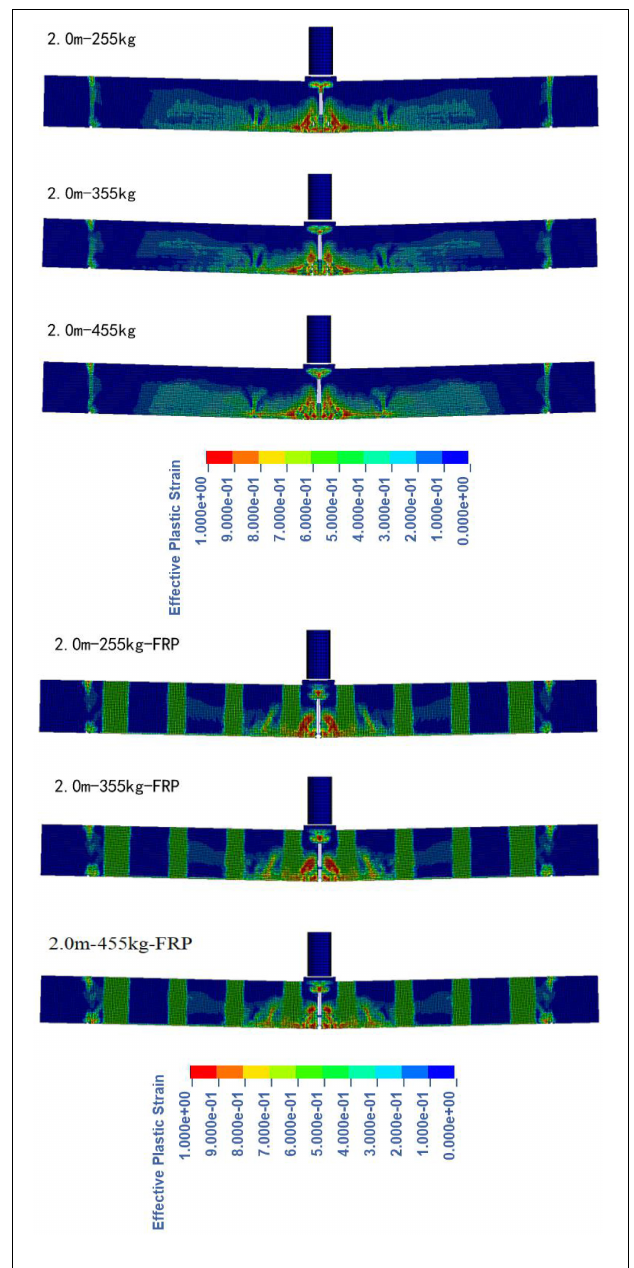
FIGURE 17 | Failure morphology under different